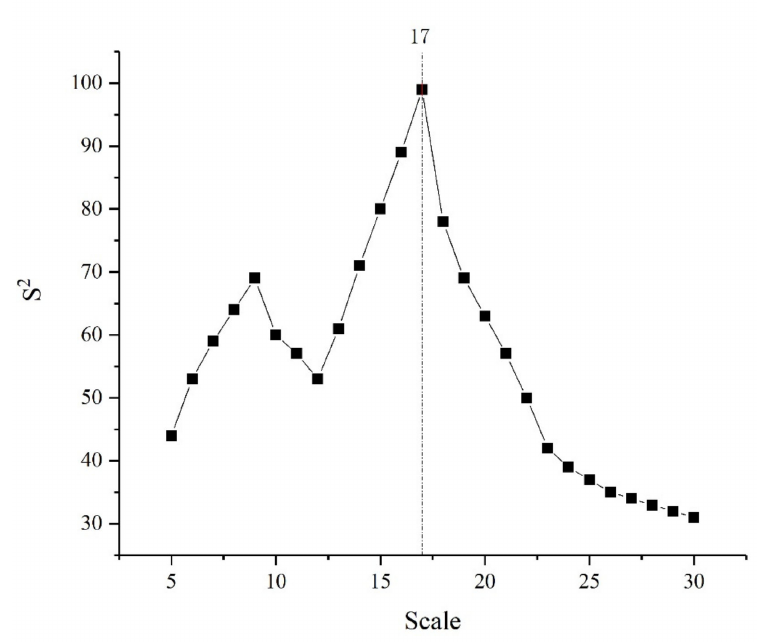
Figure 5. Weighted mean variance results of different